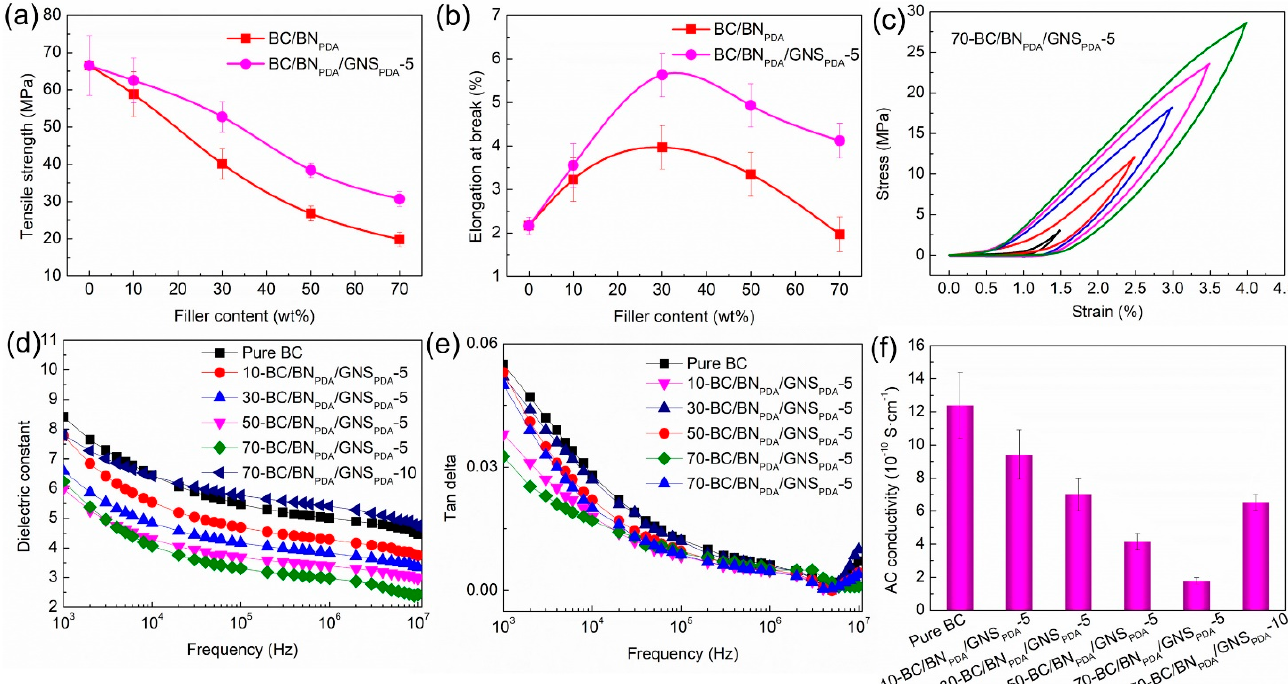
Figure 4. ( a ) Tensile strength and ( b ) elongation at break of the BC/BN PDA and BC/BN PDA /GNS PDA -5 films with different hybrid fillers contents. ( c ) The tensile recovery curves of the 70 wt% BC/BN PDA /GNS PDA -5 films. ( d ) Dielectric constant ( ε ), ( e ) dielectric loss (tan δ ), and ( f ) AC conductivity of the BC/BN PDA /GNS PDA composite films at varied hybrid fillers contents.